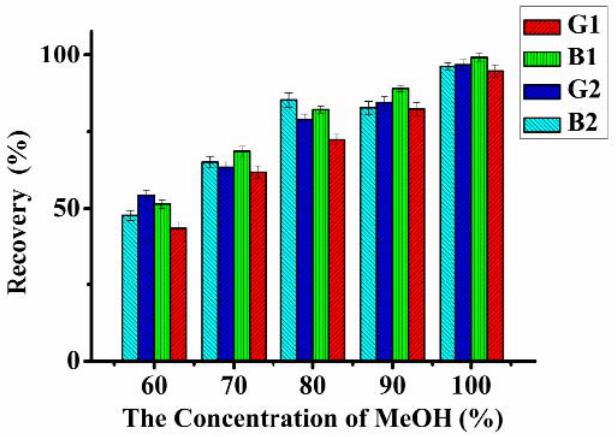
Figure 4. Effect of different eluting solvents on the efficiency of IAC (aflatoxins spiked in peanut, 5 μ g·kg − 1